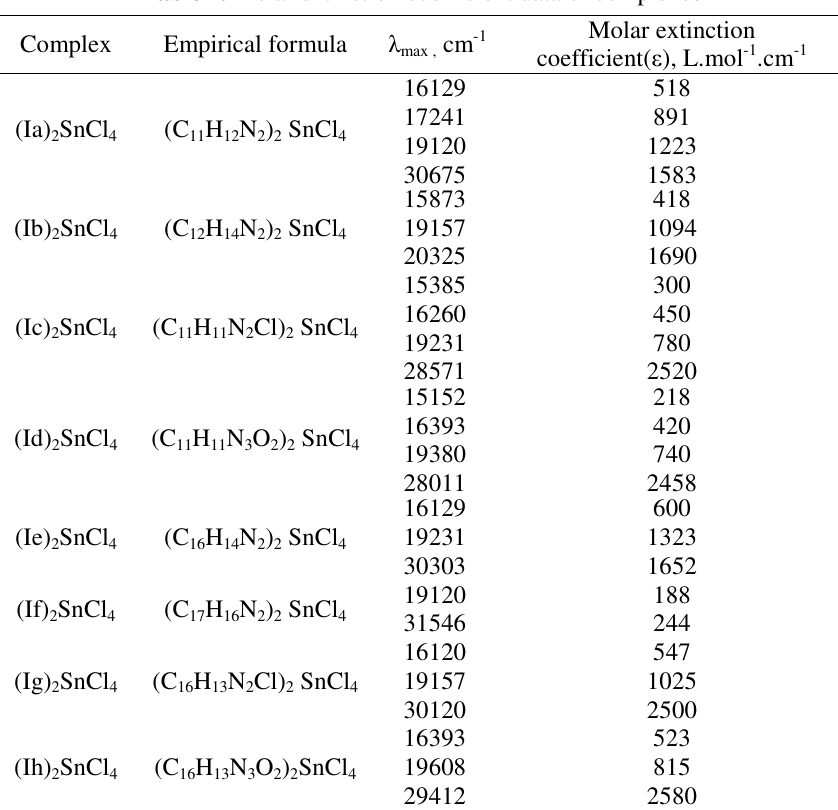
Table 2. Molar extinction coefficient data of complexes